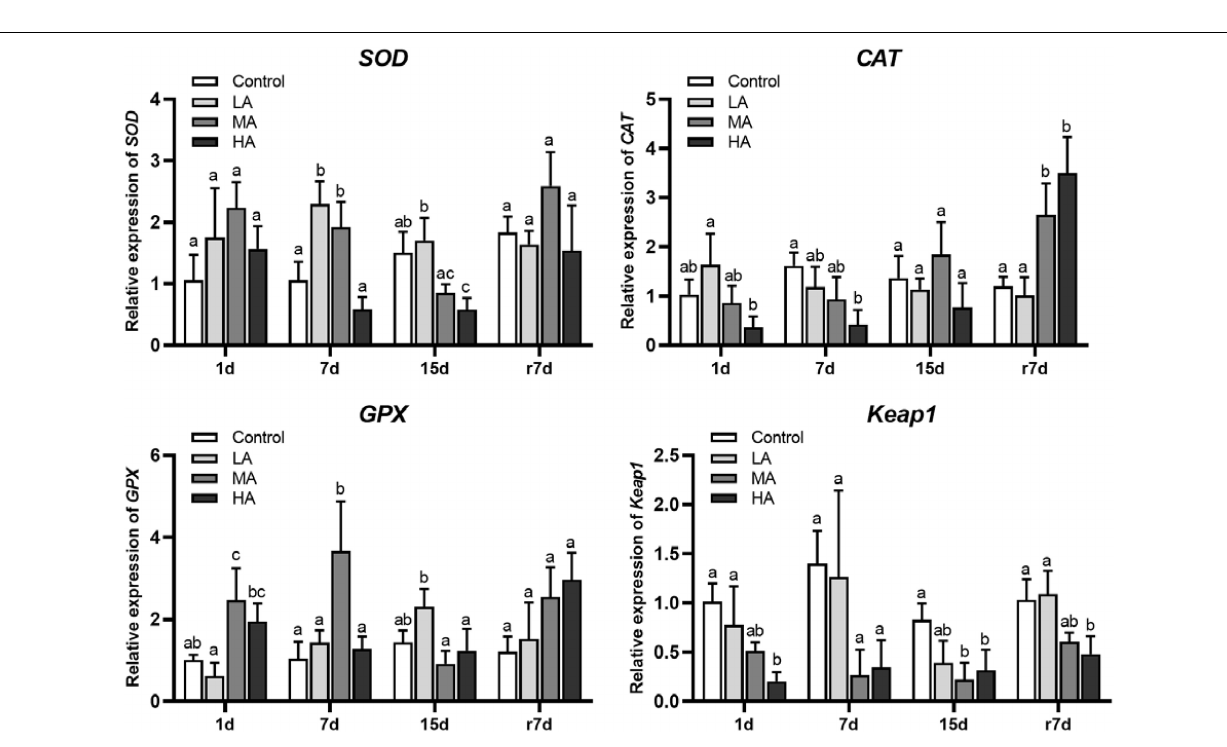
Frontiers in Marine Science |